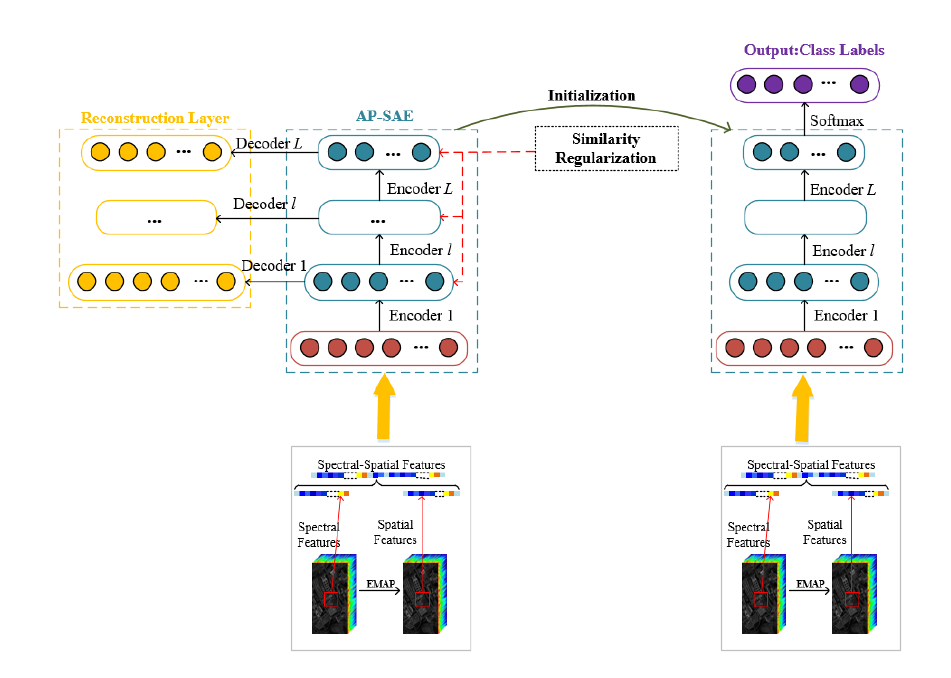
Figure 3. Outline of the proposed pixel classification strategy.